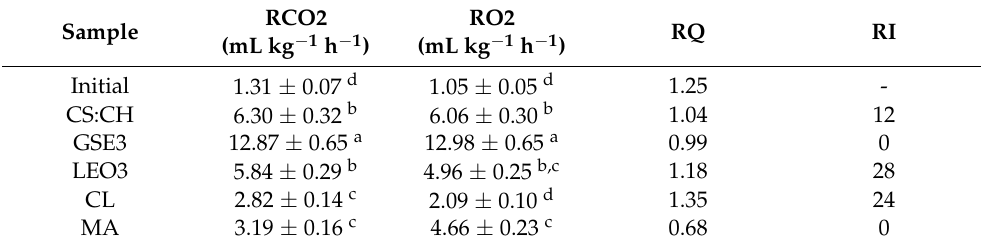
Table 1. Respiration rates (CO 2 and O 2 ), respiratory quotient at 25 ◦ C (RQ) and rot incidence (RI) of Emerald blueberries before (initial) and after 30 days of refrigerated storage for different packaging